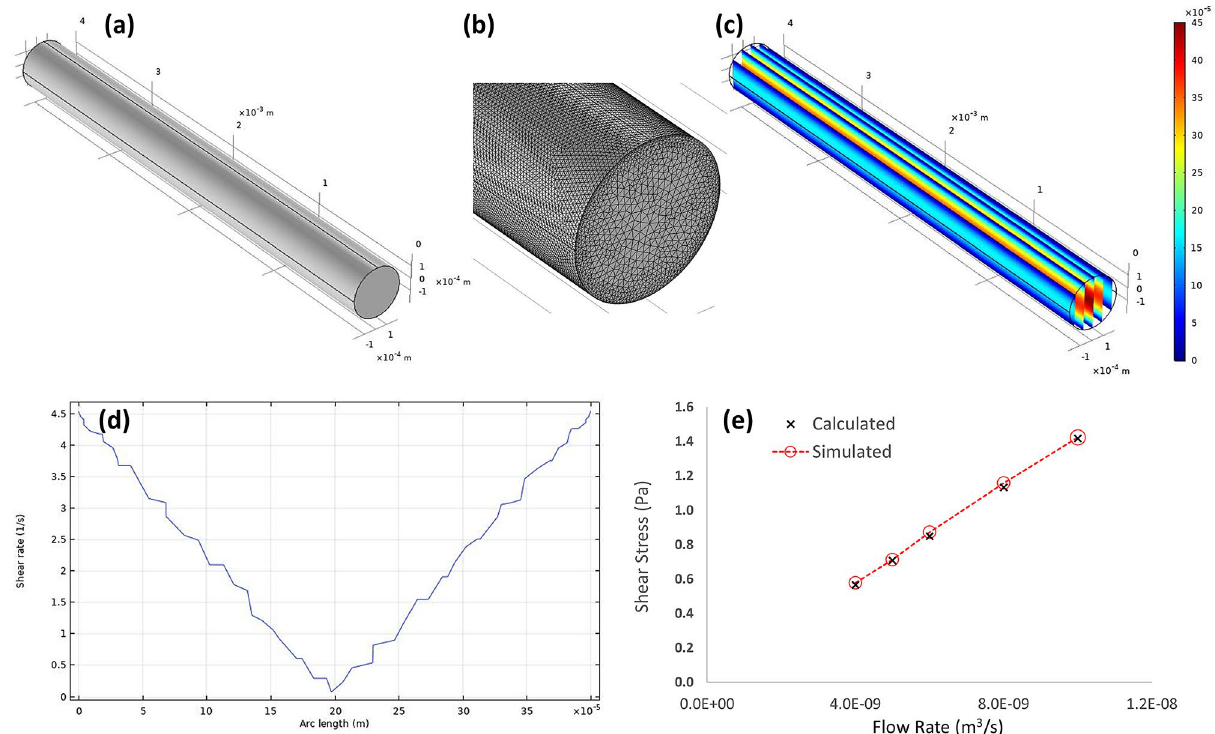
using the Newtonian fluid model, and e the wall shear-stress values calculated using Eq. 7 compared to the simulated ones using the cylindrical